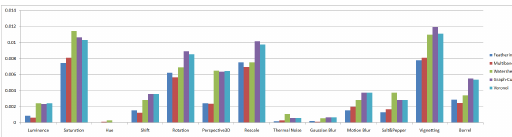
Figure 8. Distortion - Mosaicing SSIM MSE Response